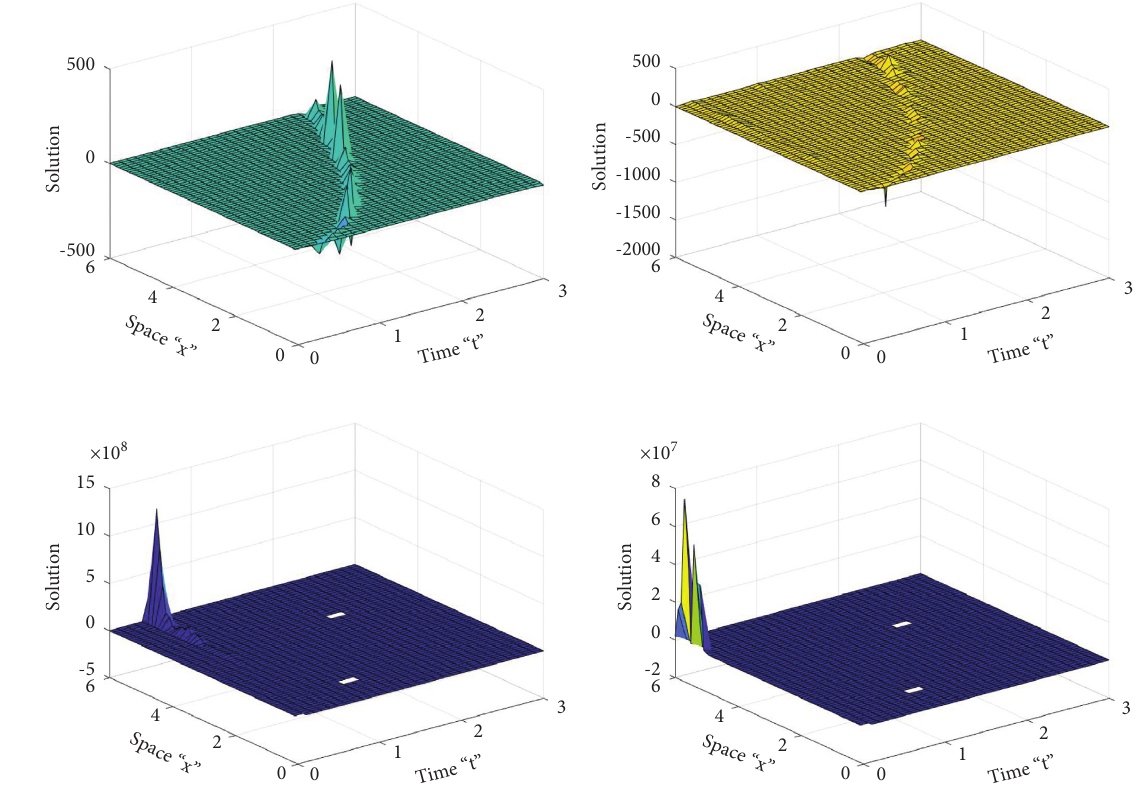
Figure 4: The solution w in equation (30) with α � 0 .